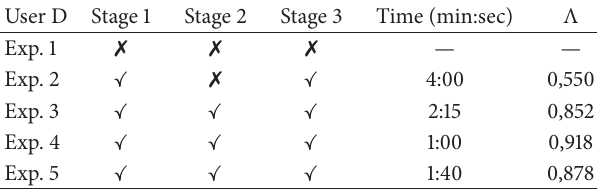
Table 4: Results of the experiment. User D.